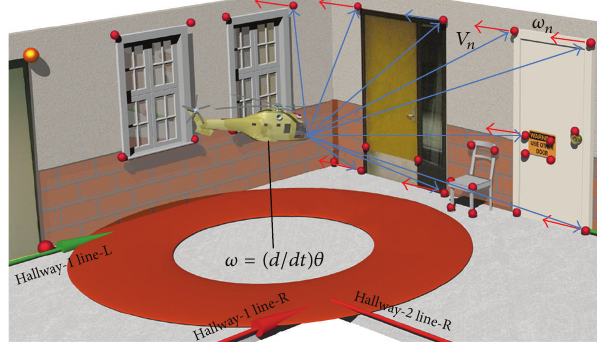
Figure 9: The helix bearing algorithm exploits the optical flow field resulting from the features not associated with architectural lines. A reducedhelixassociationsetisshownforclarity.Helixvelocitiesthat form statistically identifiable clusters indicate the presence of large objects, such as doors, that can provide estimation for the angular rate of the MAV during the